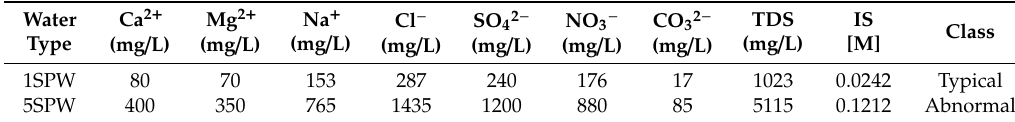
Table 1. Ion concentration in synthetic plant water (SPW).